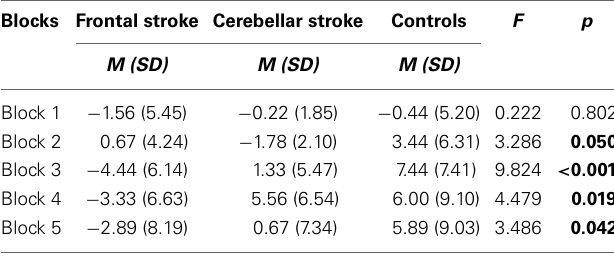
Table 2 | Group performance per block.